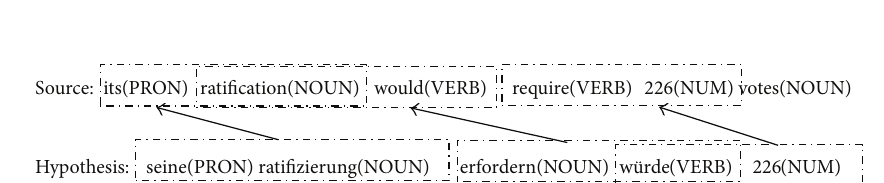
Figure 1: Universal POS alignment and NPD calculation example.